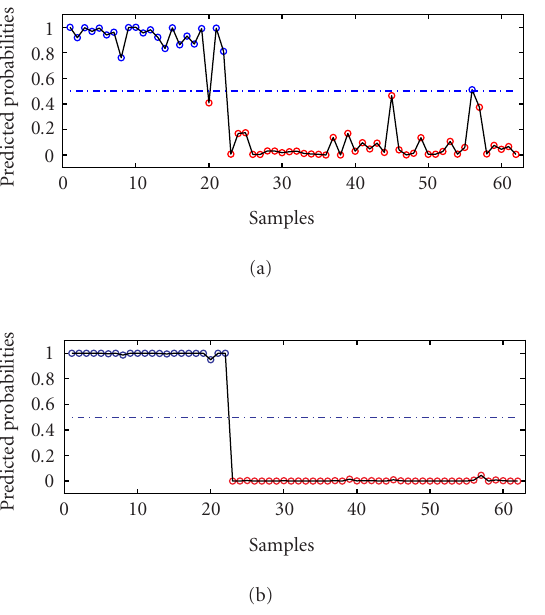
Figure 2. Outputs with (a) linear PC regression and (b) KPC classification.